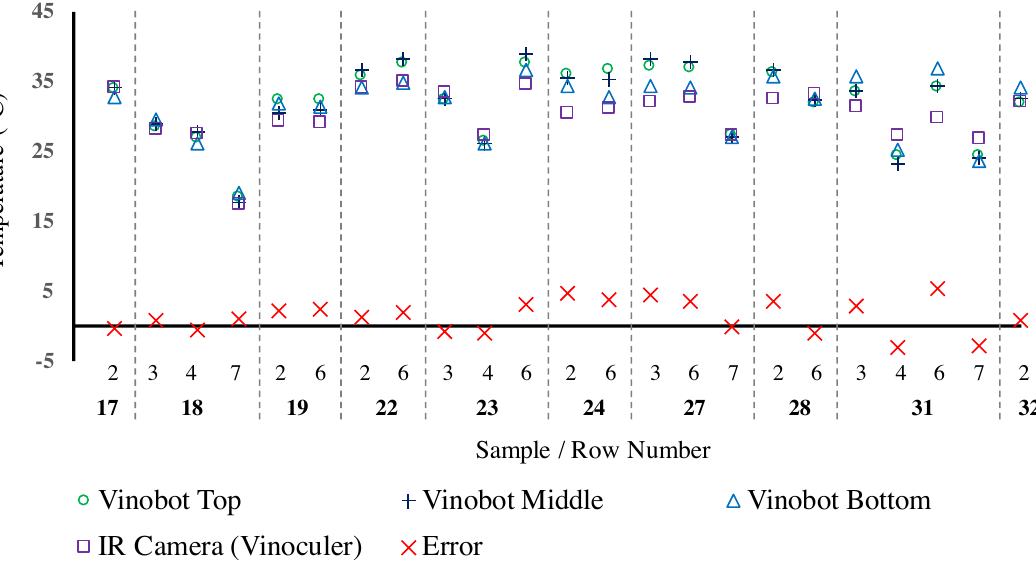
Figure 20. Correlation between the Vinobot temperature sensors and the Vinoculer IR